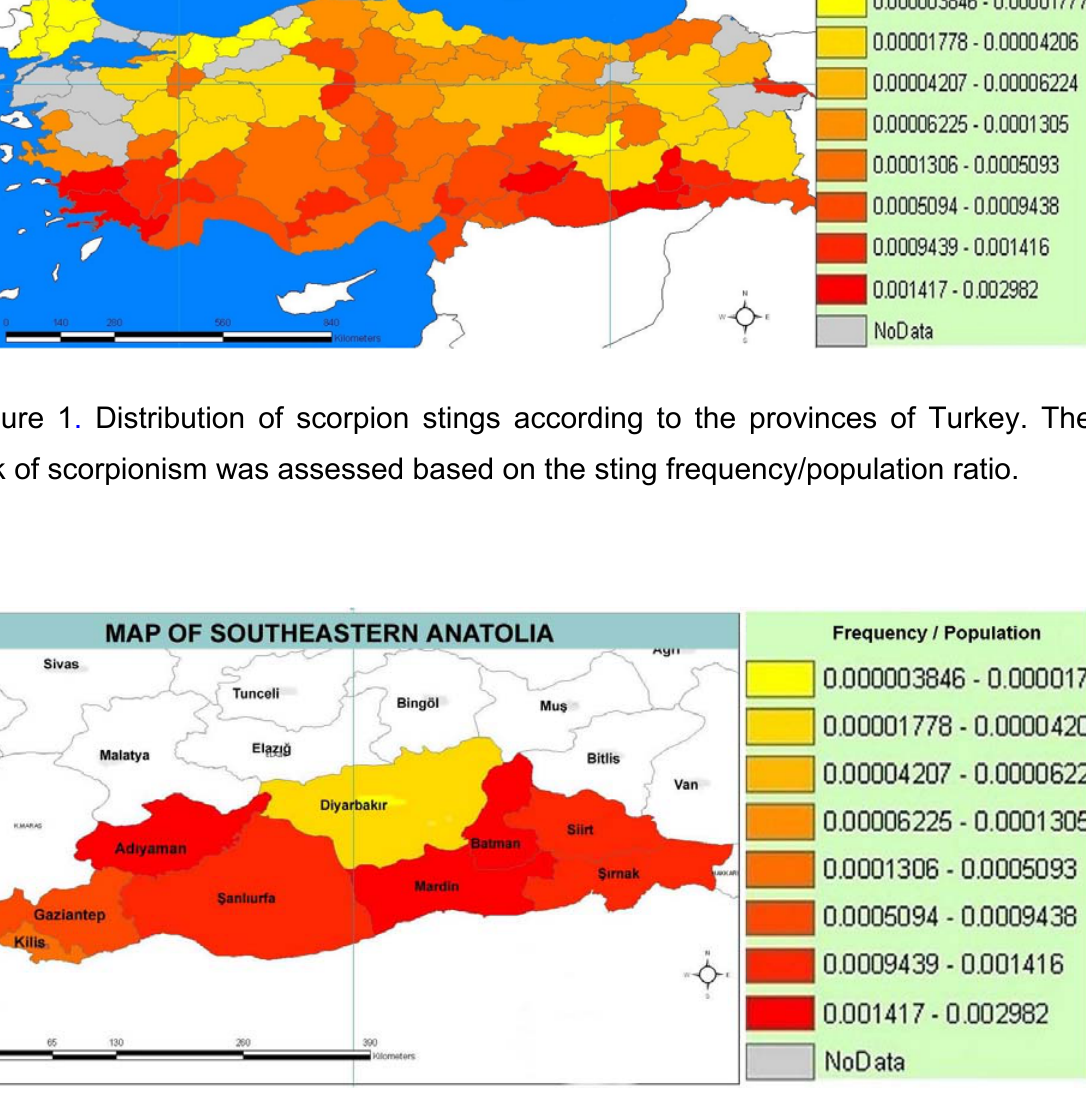
Figure 2. The Southeastern Anatolia region with its provinces according to occurrence of the highest morbidity